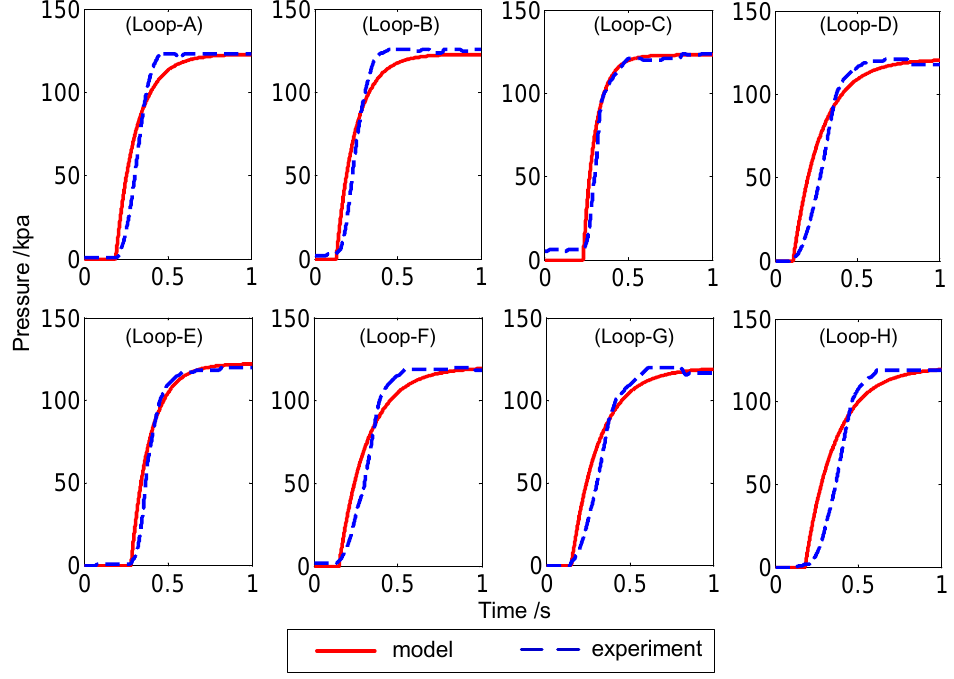
Figure 12. First-order plus time delay models and experimental results of the eight loops with the pedal opening 40%.